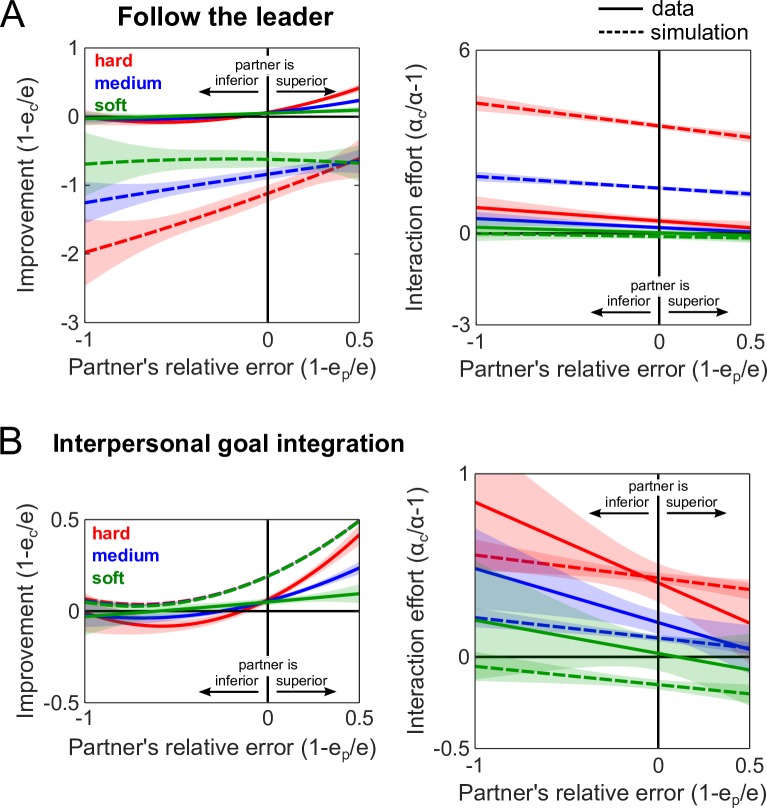
The follow the leader and interpersonal goal integration models cannot replicate the hard and soft interactions.(A) Prediction of the improvement and interaction effort from the follow the leader model, where subjects switch to following the partner’s cursor if they are nearest to the target. The prediction overestimates the interaction effort by a large amount, and greatly underestimates the performance improvement. (B) Predictions from the interpersonal goal integration model, where the visual and haptic information of the target are combined to yield a better prediction of the target’s motion. The haptic estimate of the target is obtained by forming a representation of the partner that identifies how the partner’s movement changes in response to the motion of the target, which is used to estimate the partner’s target. Unlike the data, this model does not exhibit any modulation in the improvement due to the coupling stiffness.